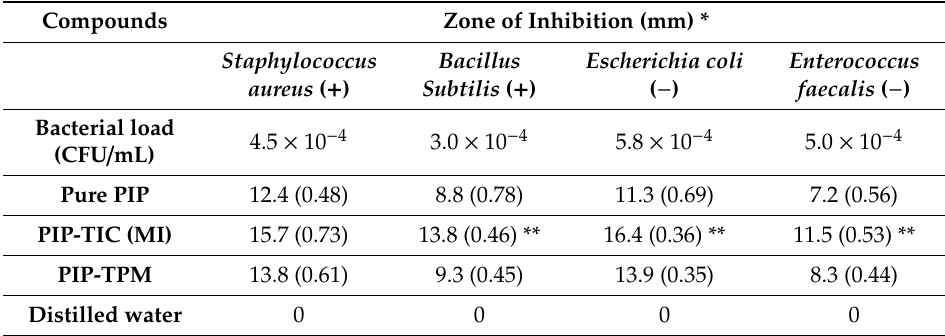
Table 2. In vitro antimicrobial assay of piperine and its complex against various strains.